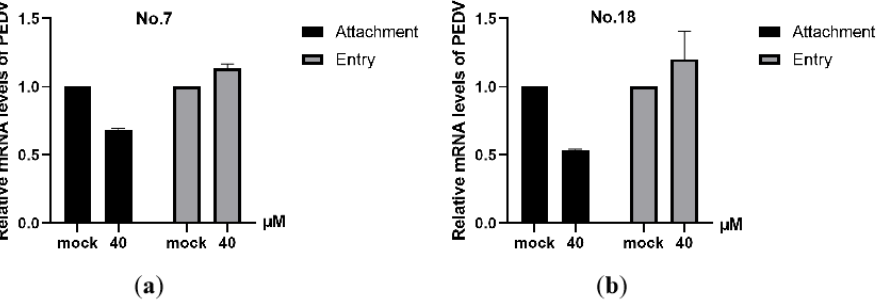
Figure 7. No.7 and No.18 carbazole derivatives inhibit PEDV attachment, but not entry. ( a , b ) Levels of vRNA in cells treated with 40 µM No.7 ( a ) or No.18 ( b ) carbazole derivatives during viral attachment and entry were determined by qRT-PCR.